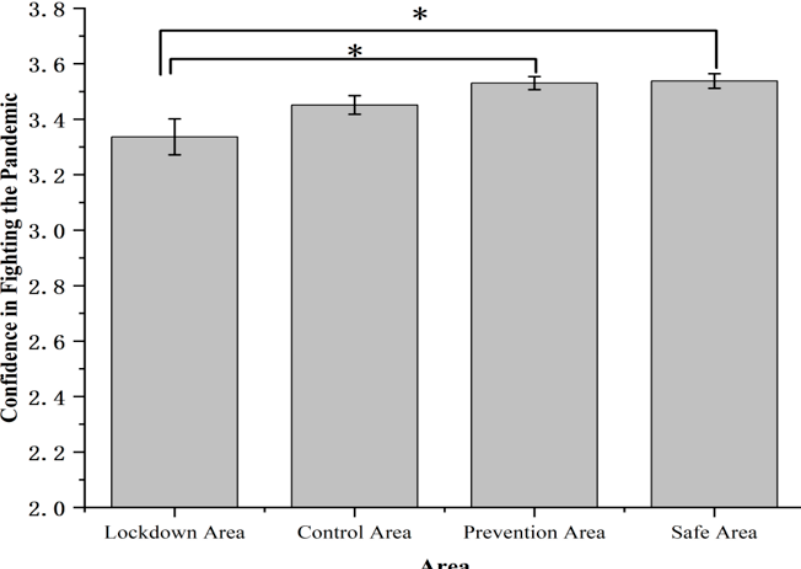
Figure 7. Confidence in fighting the pandemic. Note: The rating of confidence in fighting the pandemic was measured on a 4-point scale (1 = very negative, 2 = less negative 3 = more positive, 4 = very positive). Error bars represent standard errors. * p < 0.05.